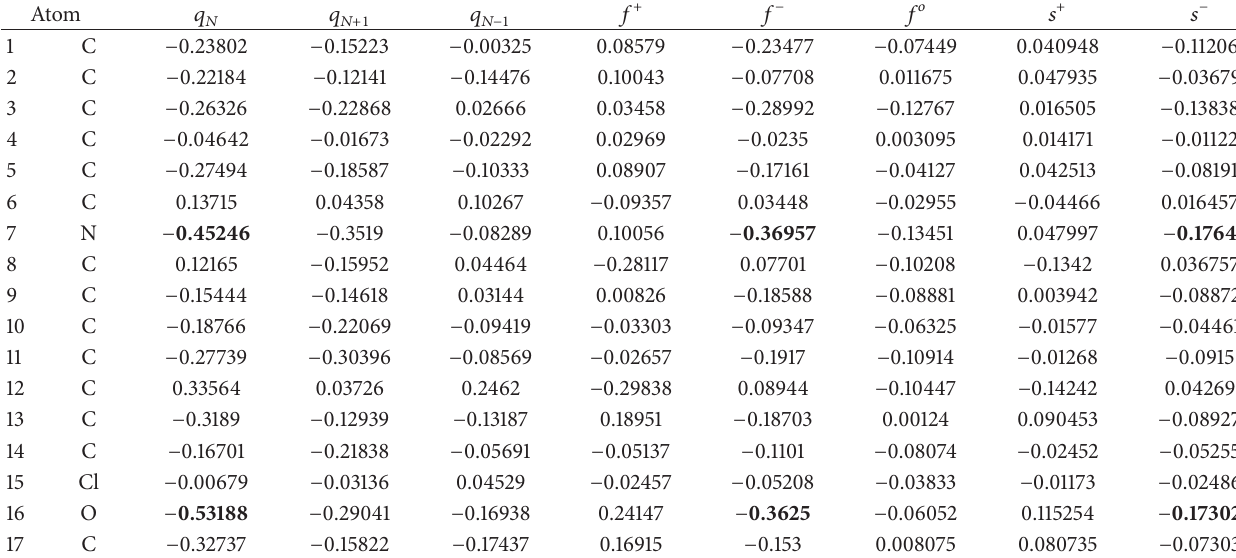
Table 4: Calculated natural charges, Fukui functions, and local softness indices for the schiff base